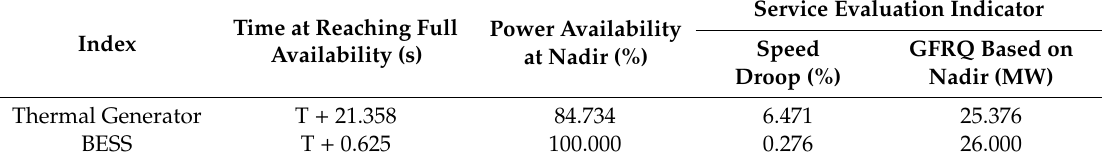
Figure 9. Comparison between the thermal generator and BESS. Table 6. Comparison of the frequency response results.